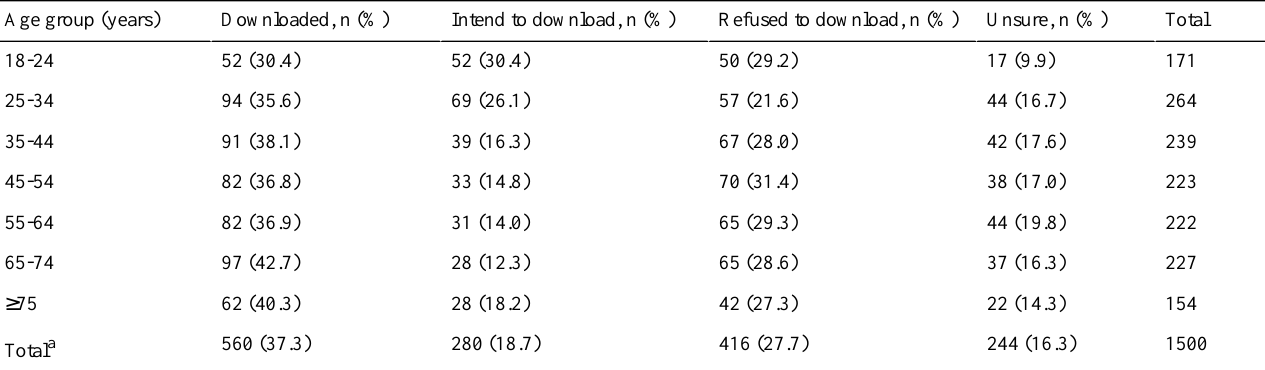
Table 3. Age groups and intentions to download the COVIDSafe